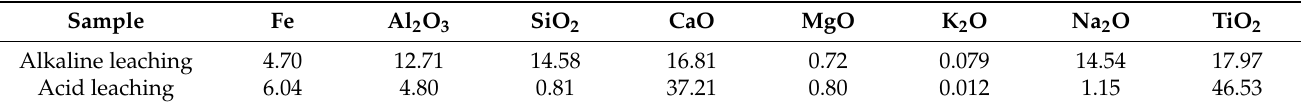
Table 6. The main chemical composition of various leaching residues